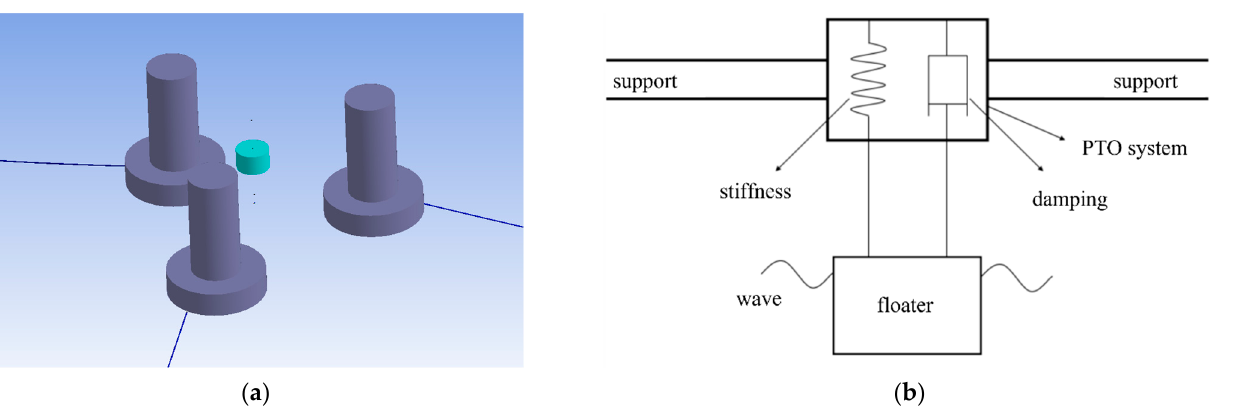
Figure 1. Schematic diagram of floating wind-wave combined power generation platform: ( a ) hydrodynamic model in ANSYS-AQWA; ( b ) simplified model of PTO system [17,18]. Table 1. Particulars of OC4 semi-submersible floating wind turbine foundation [19,20]. Geometric